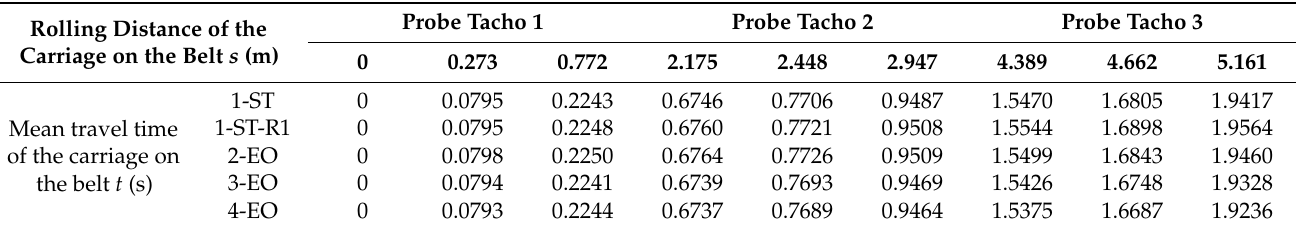
Table 3. Belt test results at a temperature of 7.5 ± 2.0 ◦ C.